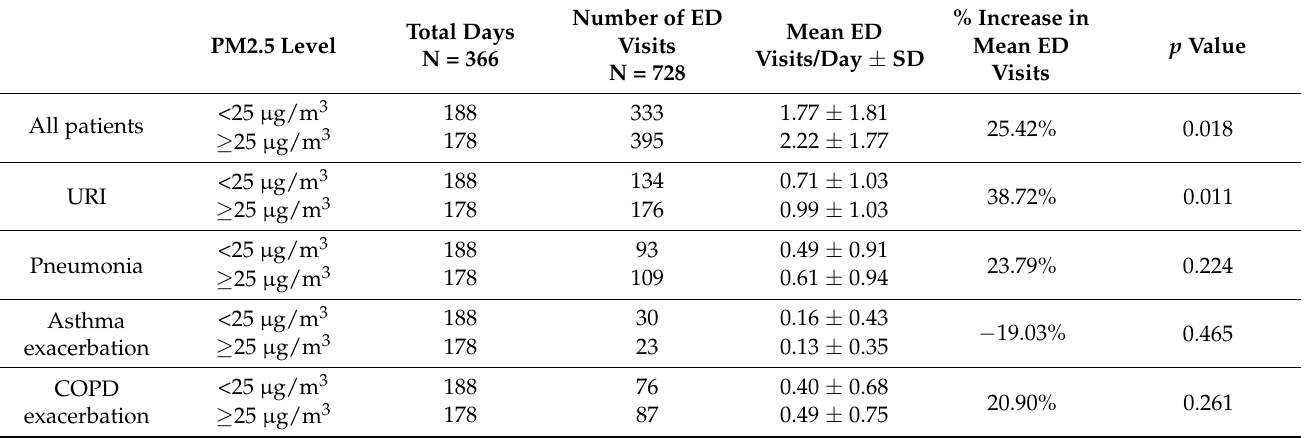
Table 1. Table presenting the number of ED visits in relation to daily PM2.5